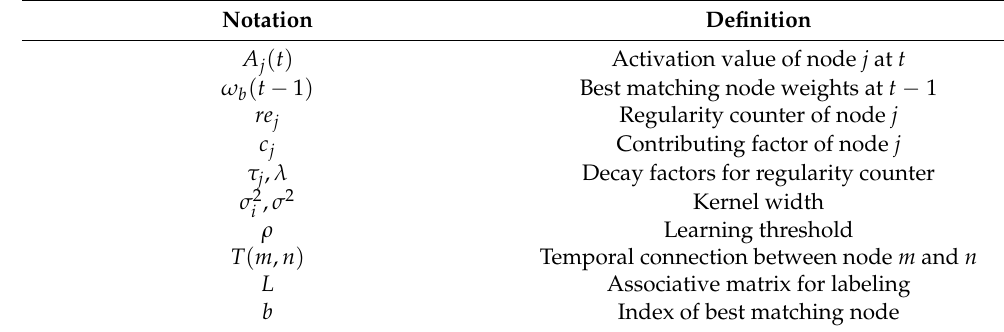
Figure 1. The architecture of the proposed MCMS system is as follows: the episodic memory layer learns the spatiotemporal features of the data through unsupervised learning. The semantic memory layer performs supervised learning using the output from the episodic memory layer and labels. Furthermore, to reinforce existing knowledge, the system automatically replays the memories using the nodes in the episodic memory layer to facilitate the overall relearning of the system. Table 1. Notation of the proposed MCMS.